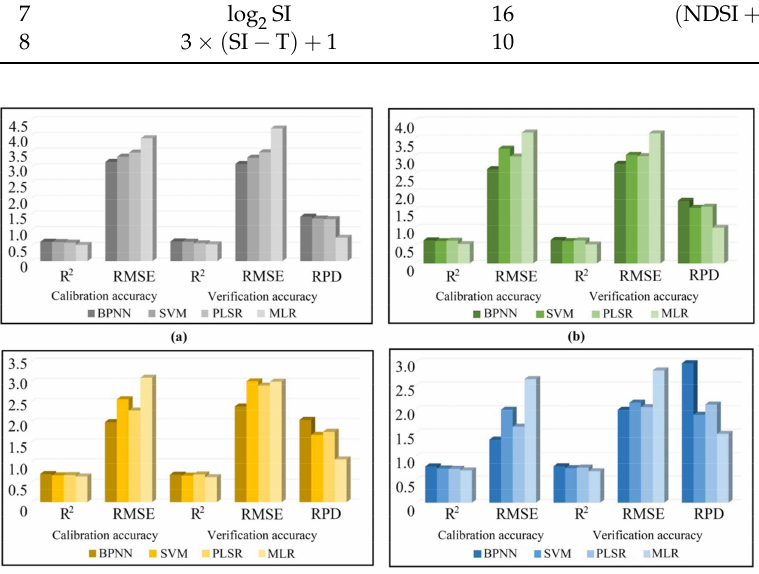
Figure 4. Accuracy statistics of ( a ) band reflectivity estimation model, ( b ) vegetation index estimation model, ( c ) soil salinity index estimation model, and ( d ) comprehensive estimation model in different modeling